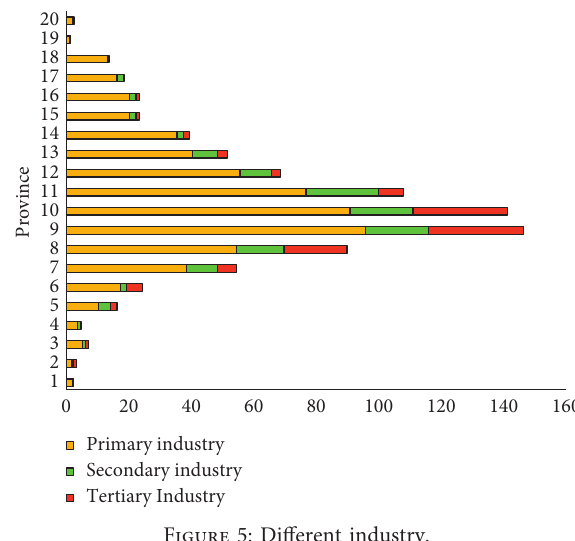
Figure 5: Different industry.